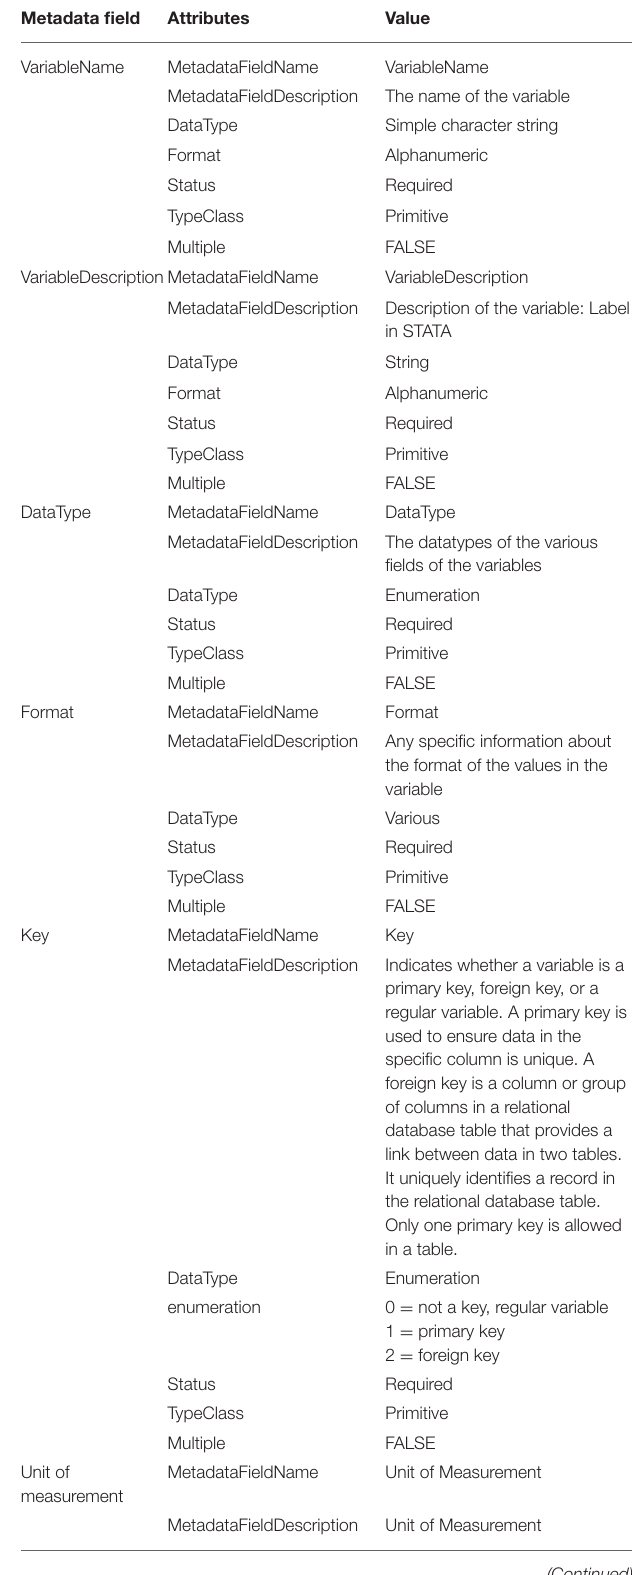
TABLE 2 | Metadata of the data